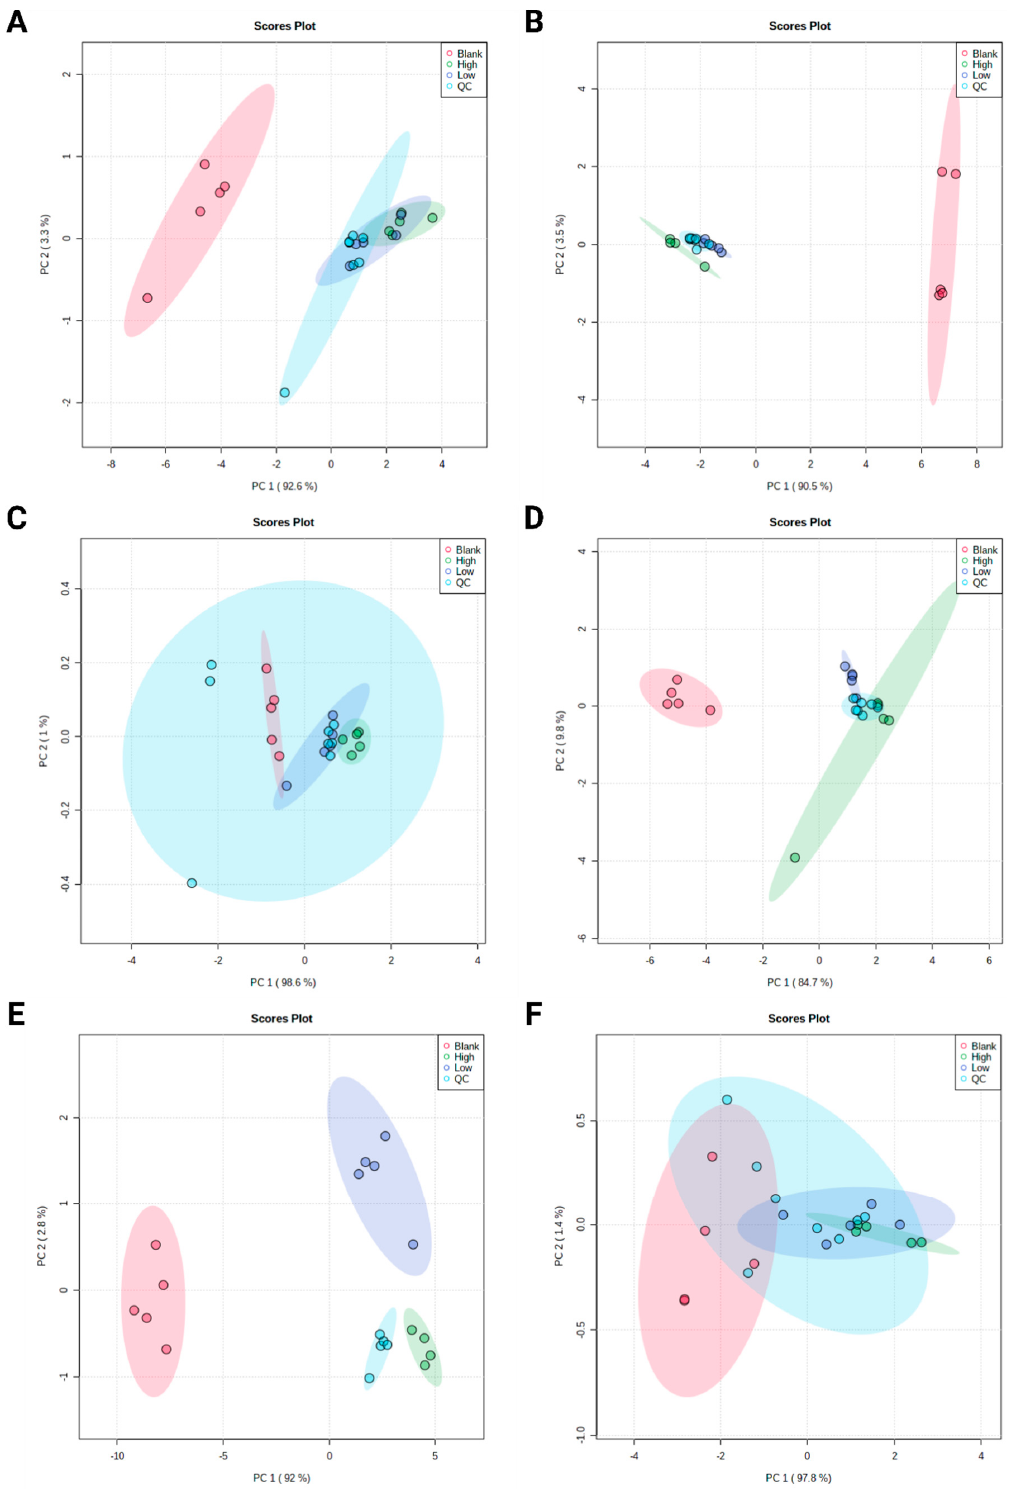
Figure 3. Scores of principal component analysis. ( A ) 4-MPD, reversed phase chromatography, positive ionization mode; ( B ) 4-MPD, normal phase chromatography, positive ionization mode; ( C ) 4-MPD, normal phase chromatography, negative ionization mode. ( D ) 4-MEAP, reversed phase chromatography, positive ionization mode; ( E ) 4-MEAP, normal phase chromatography, positive ionization mode; ( F ) 4-MEAP, normal phase chromatography, negative ionization mode, QC = pooled quality control sample